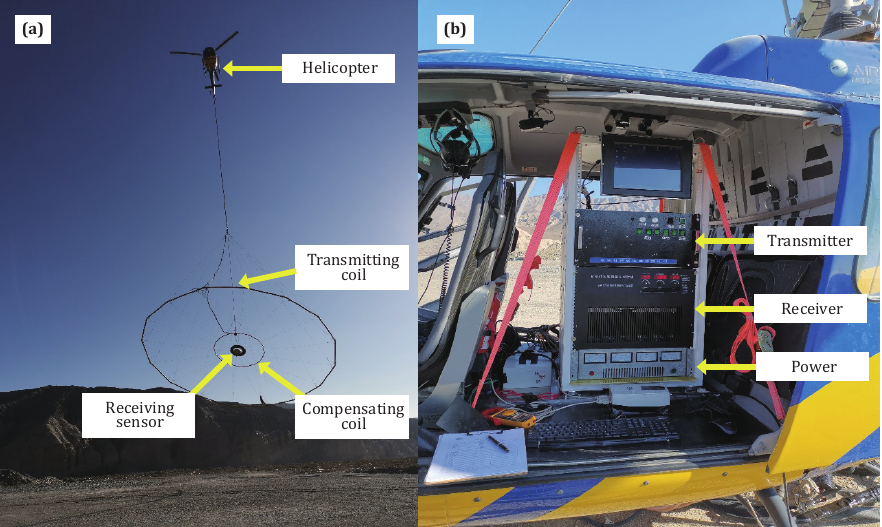
Figure 3. HTEM system on survey. ( a ) External system of helicopter cabin. ( b ) Internal system of helicopter